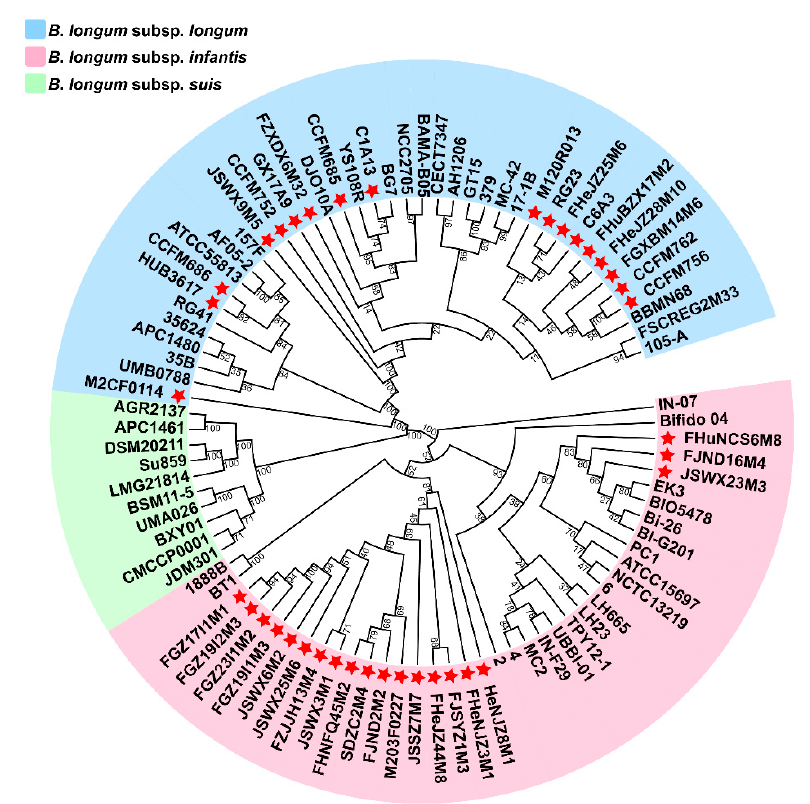
Figure 2. Phylogenetic tree of B. longum based on orthologous genes. The blue area represents B. longum subsp. longum , the red area represents B. longum subsp. infantis and the green area represents B. longum subsp. suis. The red stars represent the strains previously isolated from human faeces samples in our lab. Bootstrap values are shown on each node.